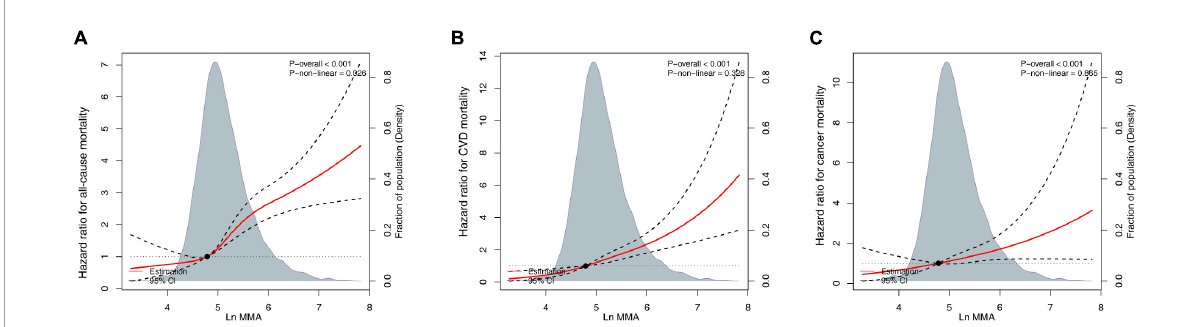
FIGURE2 Continuous dose-response associations between methylmalonic acid (MMA) and mortality. (A) All-cause mortality. (B) Cardiovascular disease (CVD)-associated mortality. (C) Cancer-associated mortality. Models adjusted for age (continuous), sex (female or male), race/ethnicity (non-Hispanic White, Mexican American, non-Hispanic Black, or other), body mass index (BMI) ( < 25.0, 25.0–30, or ≥ 30 kg/m 2 ), education level (less than high school, high school or equivalent, or college, and above), family income-poverty ratio ( ≤ 1.0, 1.0–3.0, or > 3.0), alcohol consumption (continuous), smoking status (never-smoker, former smoker, or current smoker), physical activity (vigorous activity, moderate activity, or inactivity), vitamin B12 (pmol/L, continuous), and diabetes medication use (no insulin or pills, only diabetes pills, only insulin, or pills and